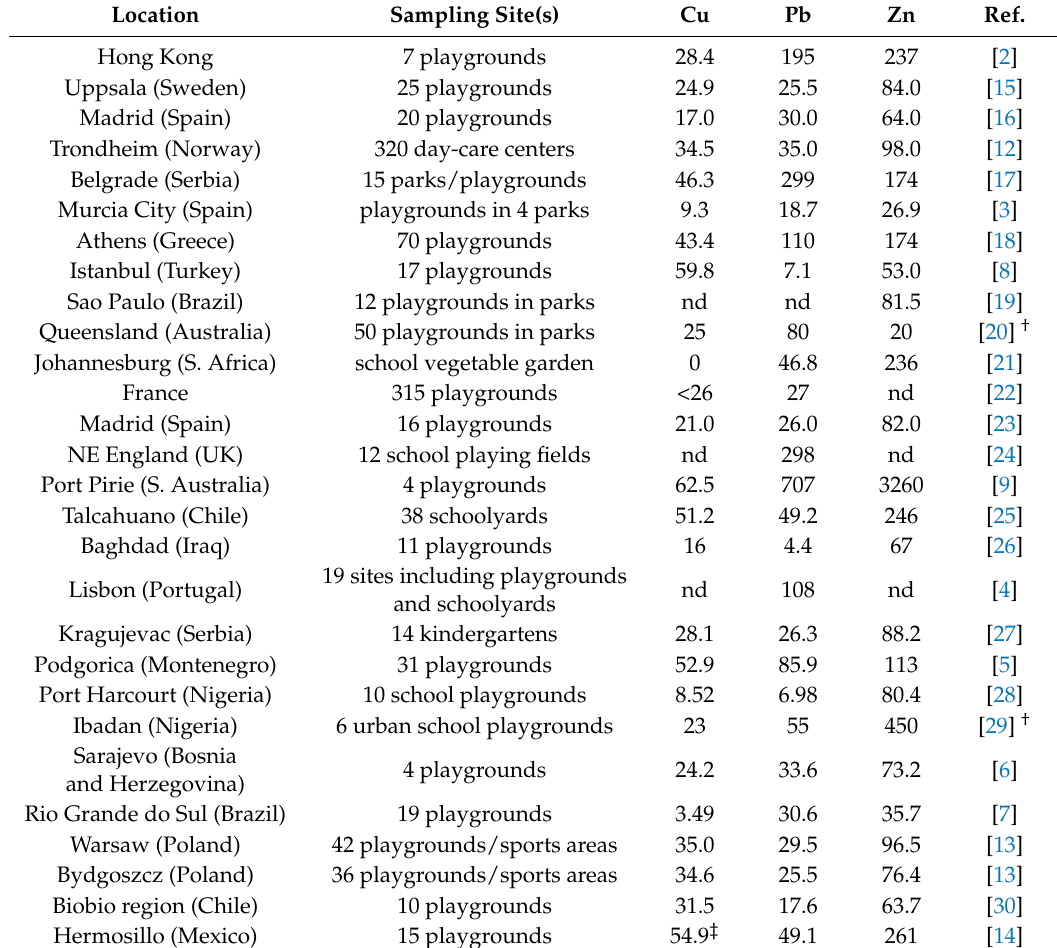
Table 1. Concentrations of copper, lead and zinc in some playground soils worldwide (mg · kg − 1